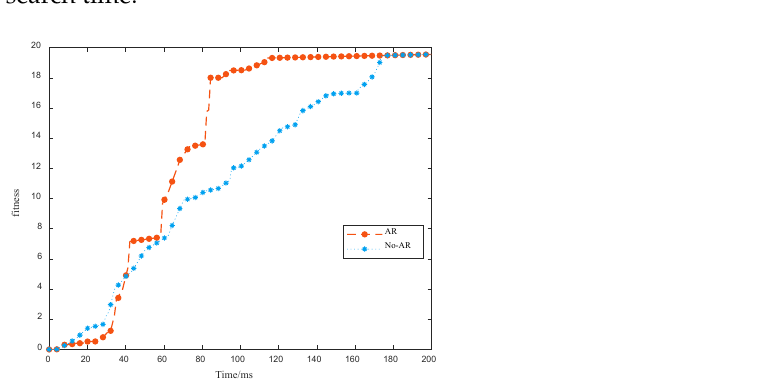
Figure 9. Target-discovery benefits under two scenarios with the same algorithm.